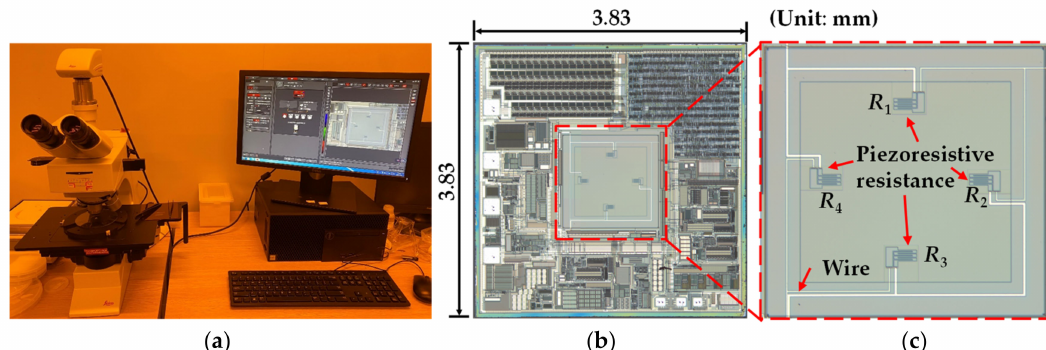
Figure 1. MEMS pressure sensor.